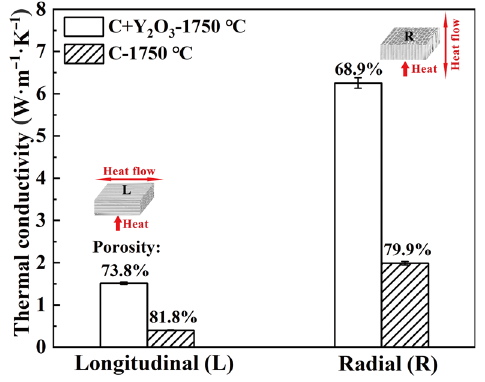
Fig. 6 Anisotropic TC of wood-derived bio-Si 3 N 4 ceramics sintered at 1750 ℃ for 4